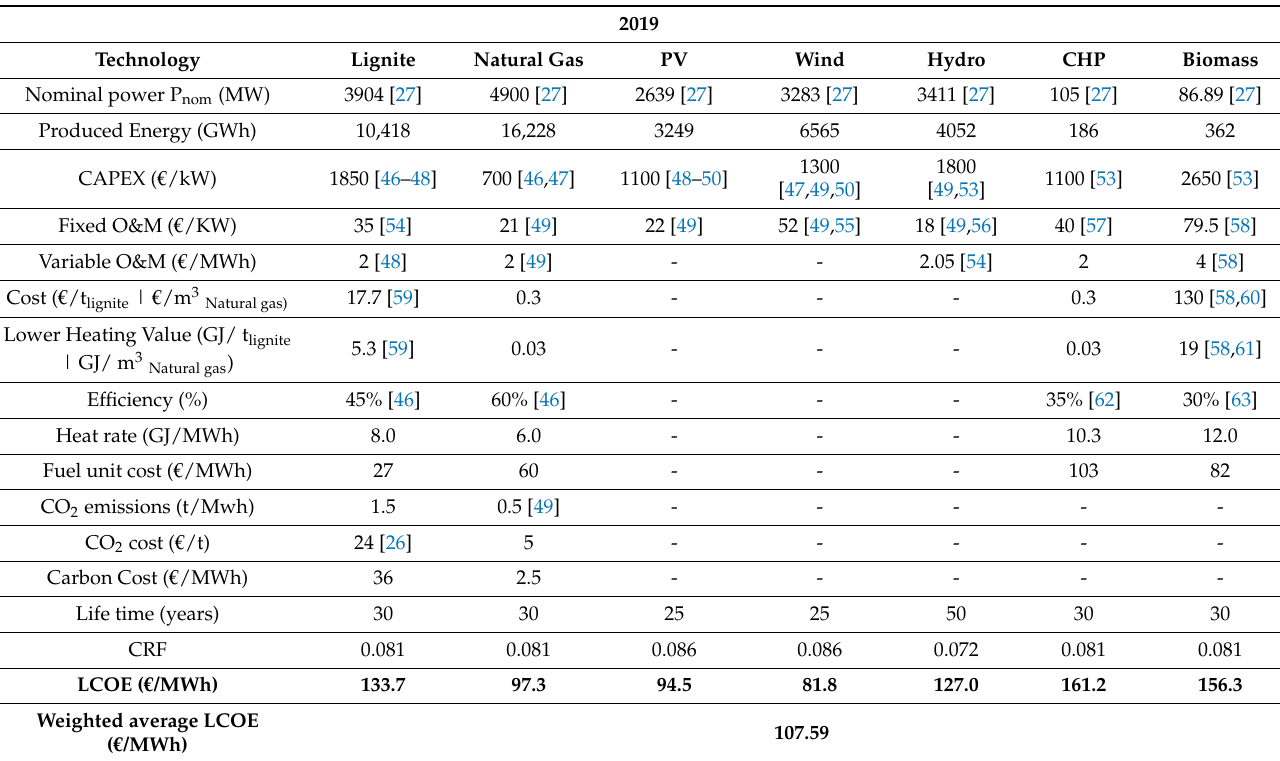
Table 4. Data used for LCOE calculation for 2019.